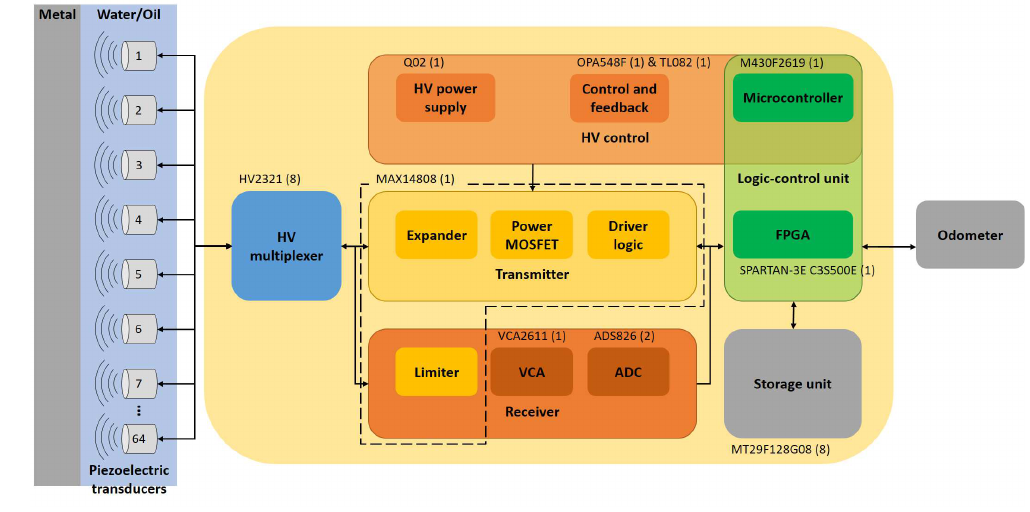
Figure 4. Ultrasound system with the pulse generator control-loop proposal for automatic pipeline